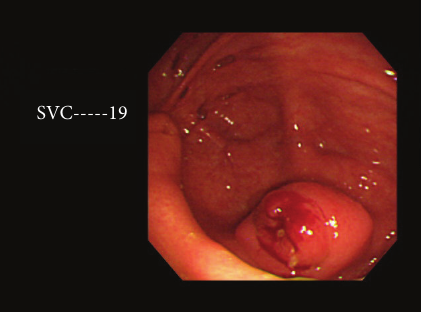
Figure 2: Colonoscopic findings at the level of cecum. Appendiceal orifice is seen. It shows mucosal erosions and irregularities.